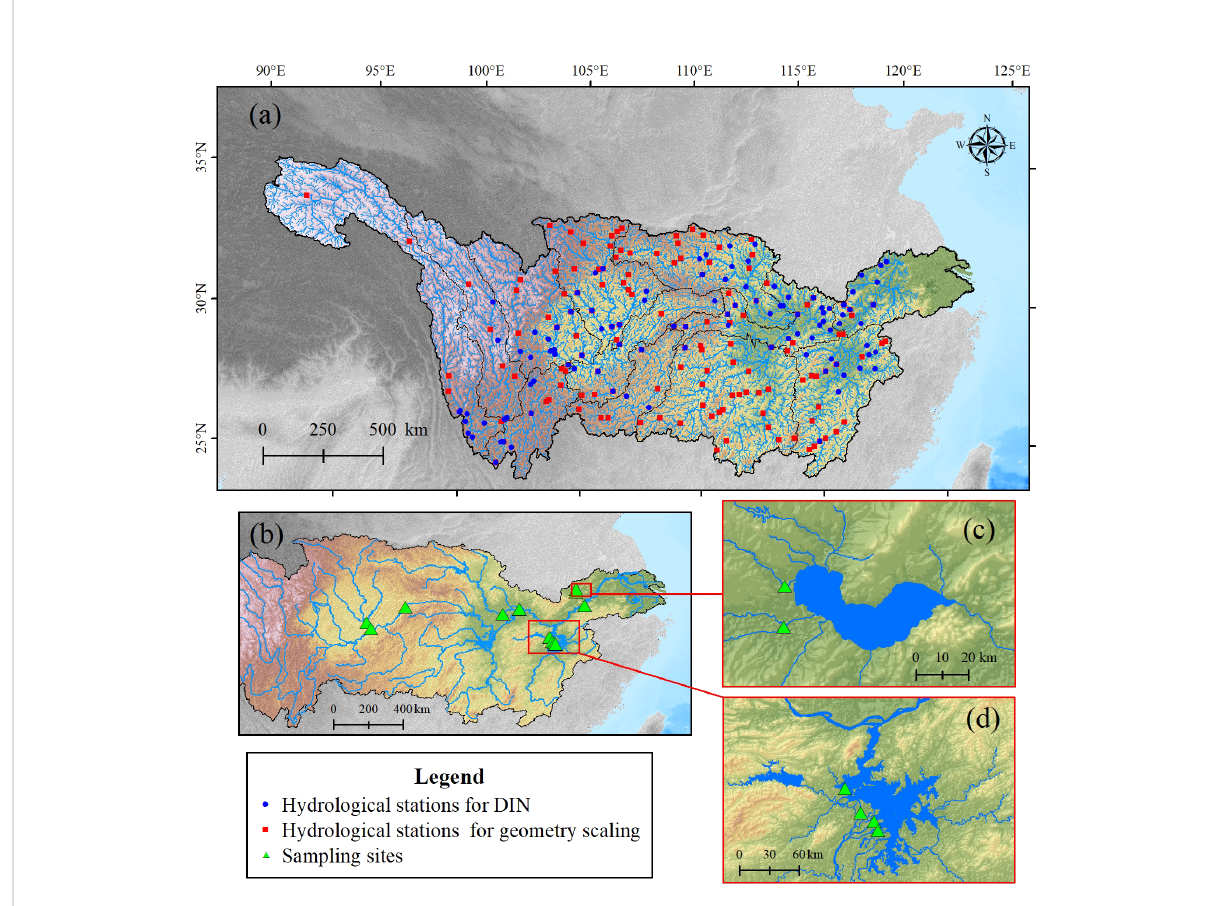
FIGURE 1 Location and river network of the Changjiang River basin, (A) showing the river network and hydrological stations, (B) all sampling sites, (C) sampling sites in Chaohu Lake watershed, and (D) sampling sites in Poyang Lake